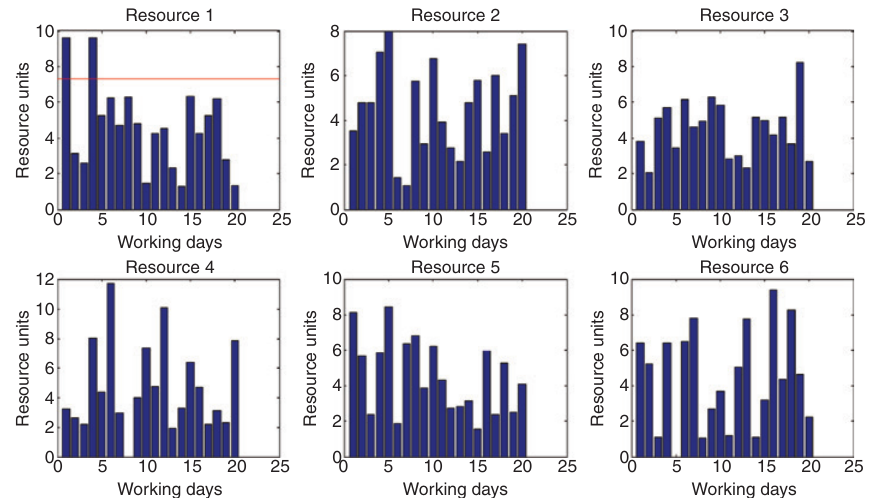
Figure 13: Resource Utilization with